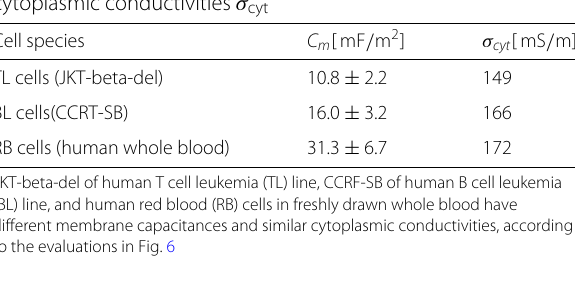
Table 1 Comparison of membrane capacitances C m